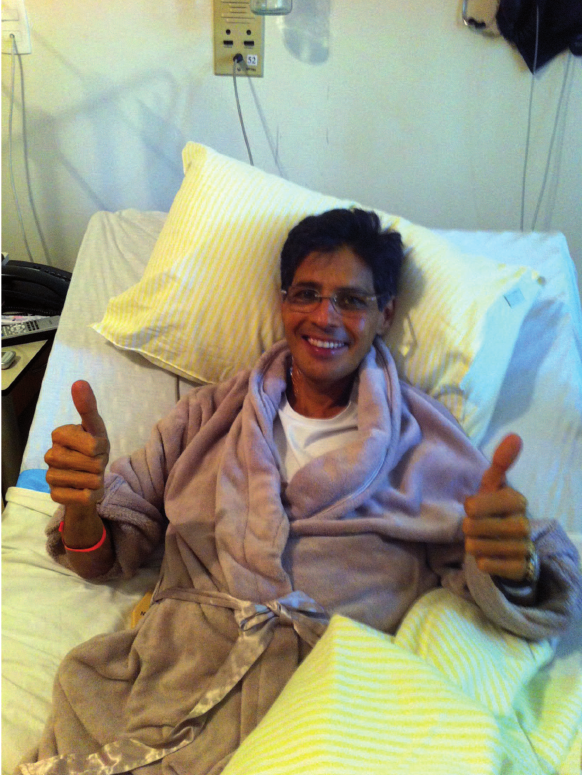
Fig. 2 - Durante cerca de 3 anos, o Dr. Gerola lutou bravamente contra o câncer, sempre mostrando otimismo contagiante As condições de trabalho e financeiras levaram o Gerola a buscar e ter “serviços” próprios (ou com associados) em Taubaté (SP) (1993-1995) e em Cuiabá (1995-1996).